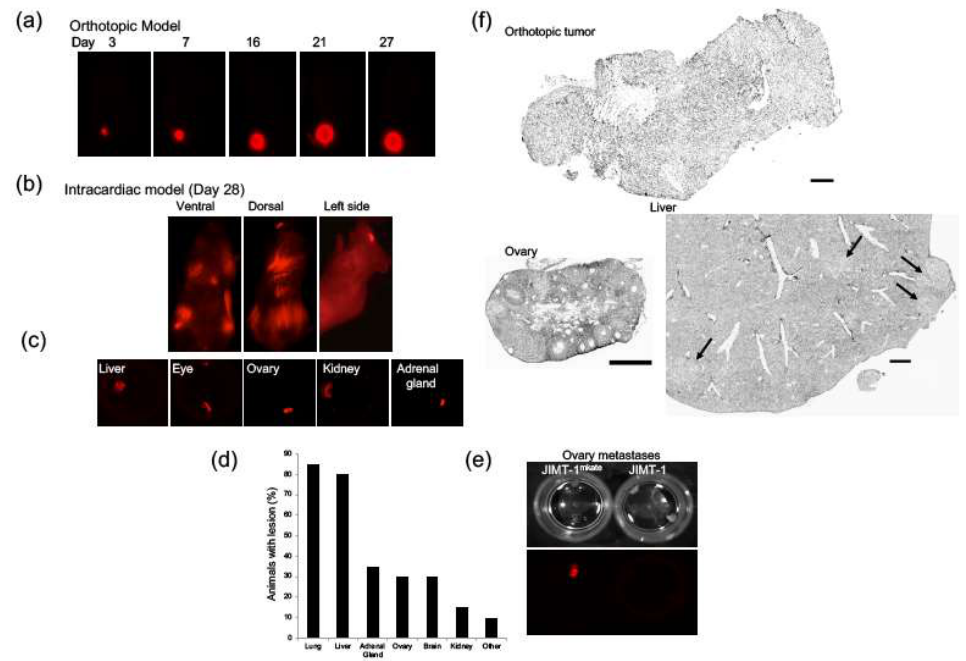
Figure 1. JIMT-1mKate cells (red) were inoculated in the mammary fat pad or left ventricle of female NCr nude mice. Subsequently, solid tumor ( a ) and metastatic ( b ) progression was followed using Maestro imaging. Organs excised from animals were imaged ex vivo using Maestro imaging ( c ). Disease consistently developed in the liver, lungs, kidney, ovaries, adrenal gland, and brain ( d ). Tumor-positive ovaries from animals inoculated with JIMT-1mKate and JIMT-1 cells were used as a positive and negative control respectively, to optimize Maestro imaging ( e ). Tumors and metastatic lesions were excised and subject to hematoxylin staining ( f ). Selected images show an orthotopic tumor (top bar = 250 µm), a tumor-infiltrated ovary (bottom, left, bar = 500 µm), and tumor nodules in the liver (arrows, bar = 250 µm).